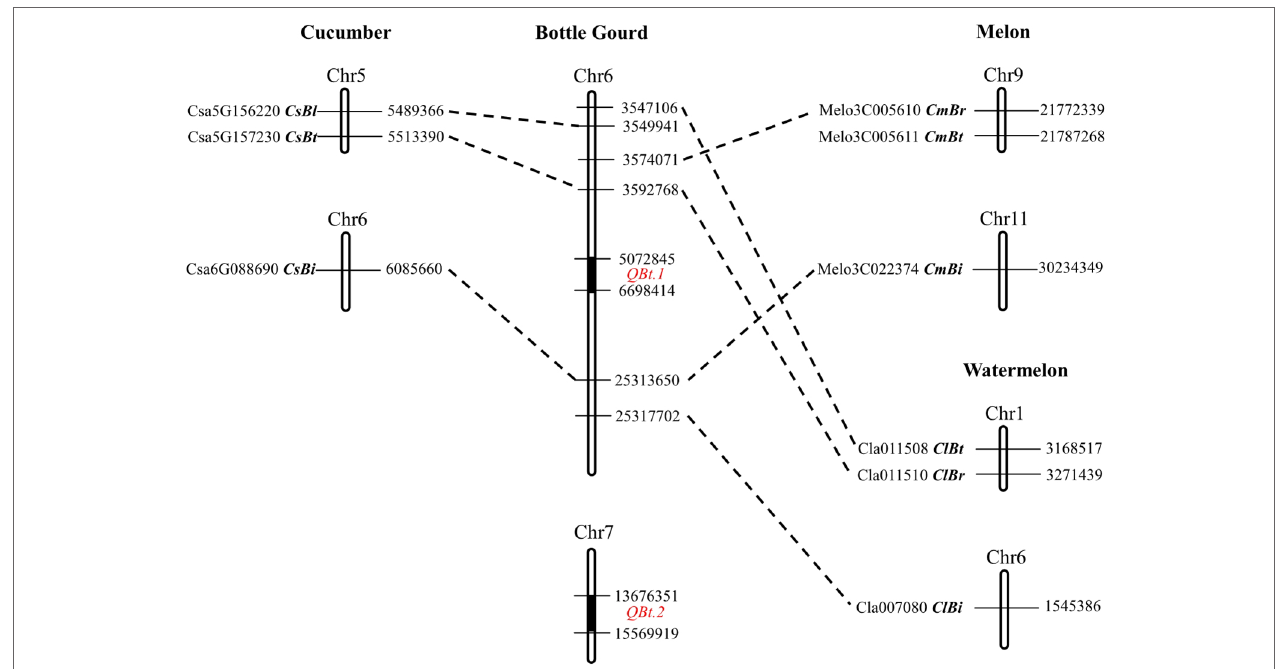
FIGURe 3 | Genomic synteny of the bitterness genes between bottle gourd, cucumber, melon. and watermelon.